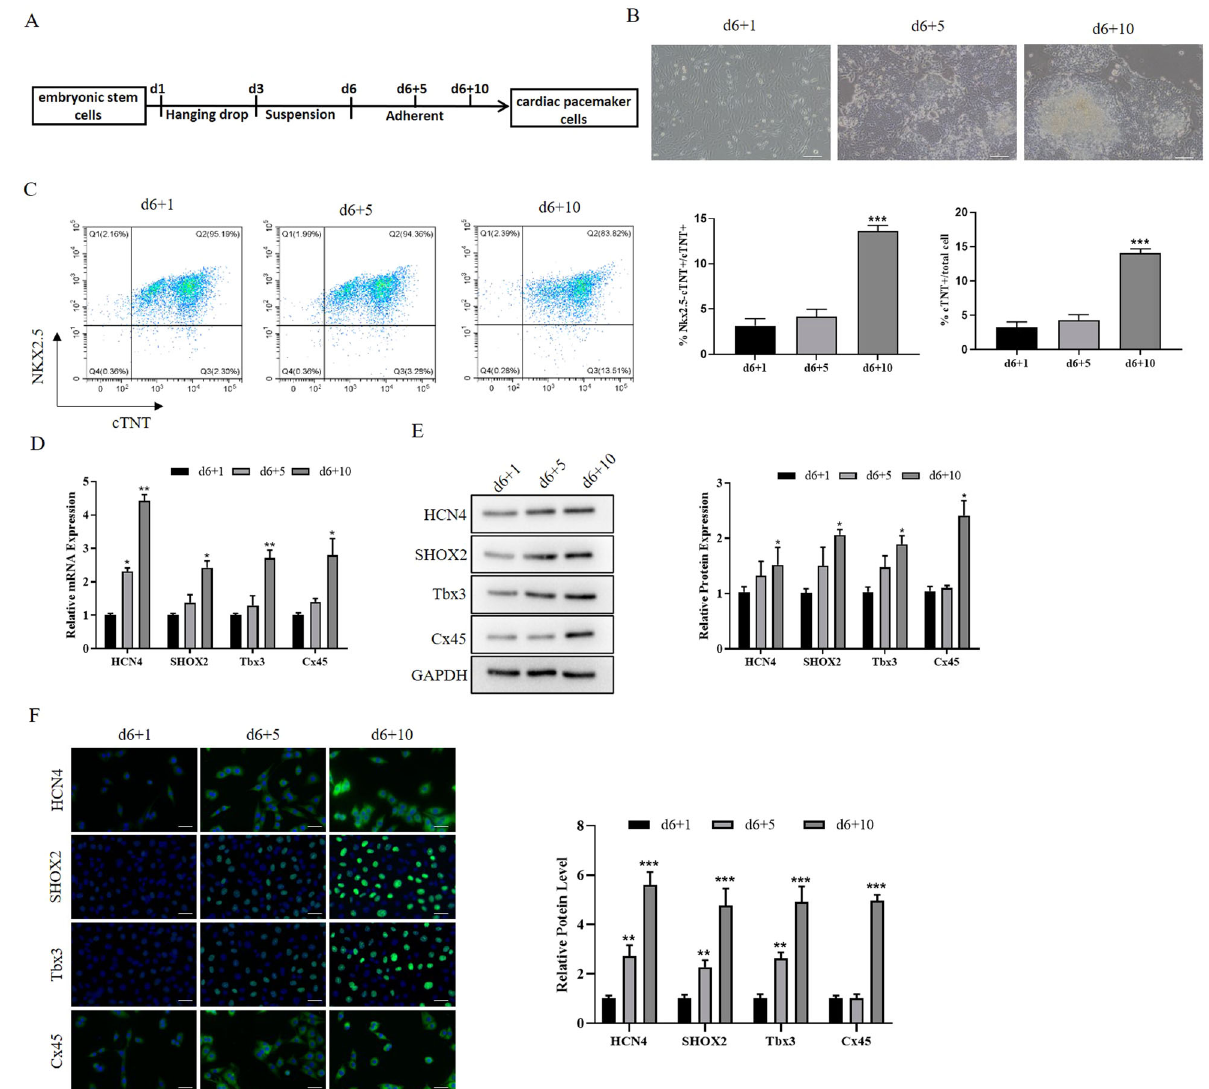
Fig. 1 ESCs differentiated into cardiac pacemaker-like cells. A The diagram showing the differentiation of ESCs into pacemaker-like cells; B cell morphology of differentiated ESCs at d1, d5, and d10. C Flow cytometry detected the ratio of pacemaker-like cells at d1, d5, and d10. D qRT-PCR detected the expression of pacemaker-related genes at mRNA levels. E Western blot detected the expression of pacemaker-related genes at protein levels. F IF was used to detect the expression of pacemaker-related genes. * P < 0.05, ** P < 0.01, * as the difference that compared with the d6 + 1 cells. Error bars were represented the mean ± SD in triplicate